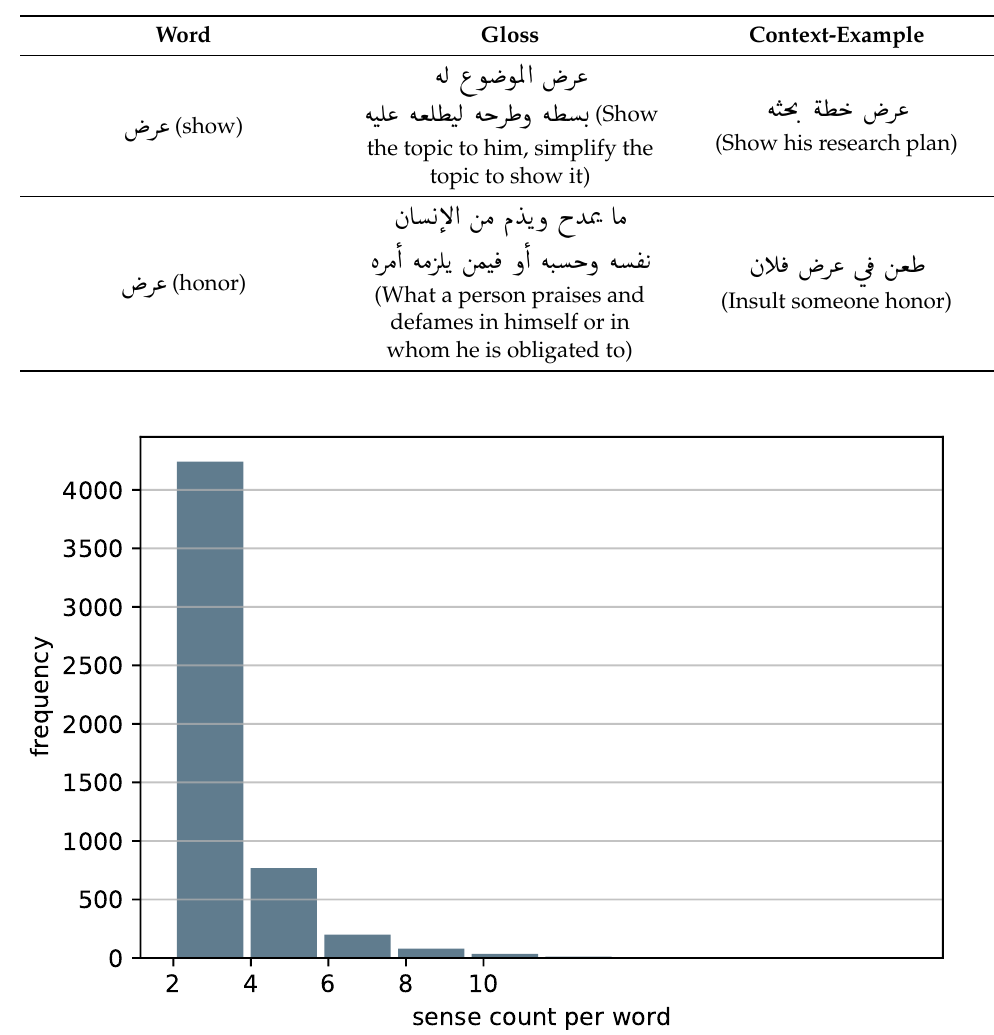
Table 2. Benchmark example.